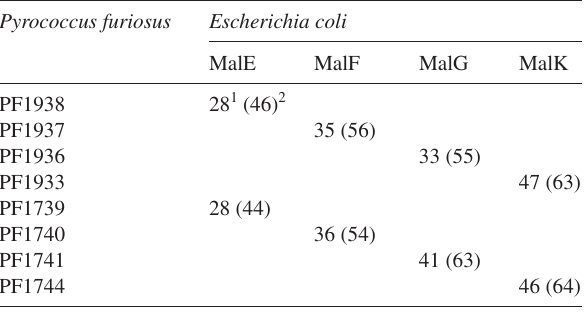
Table 1. Homology between Pyrococcus furiosus and Escherichia coli maltose/maltodextrin transporter clusters.